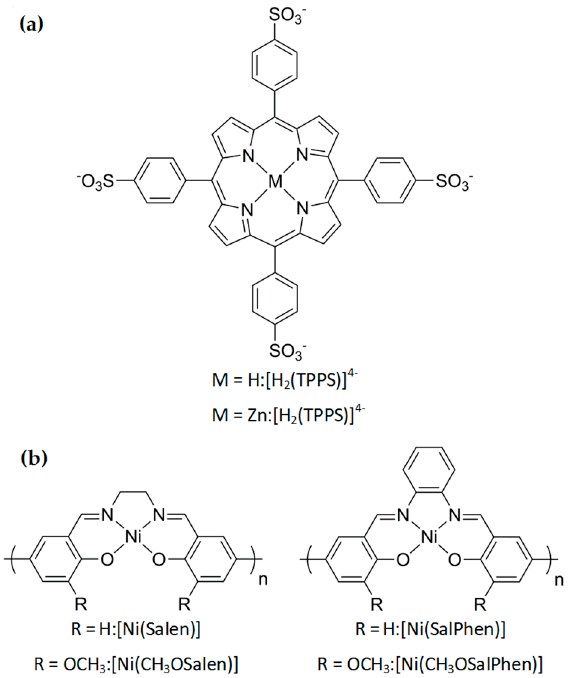
Figure 1. ( a ) Structure of the NiSalen polymers; ( b ) Structure of the MTPPS porphyrins, employed in the present study.